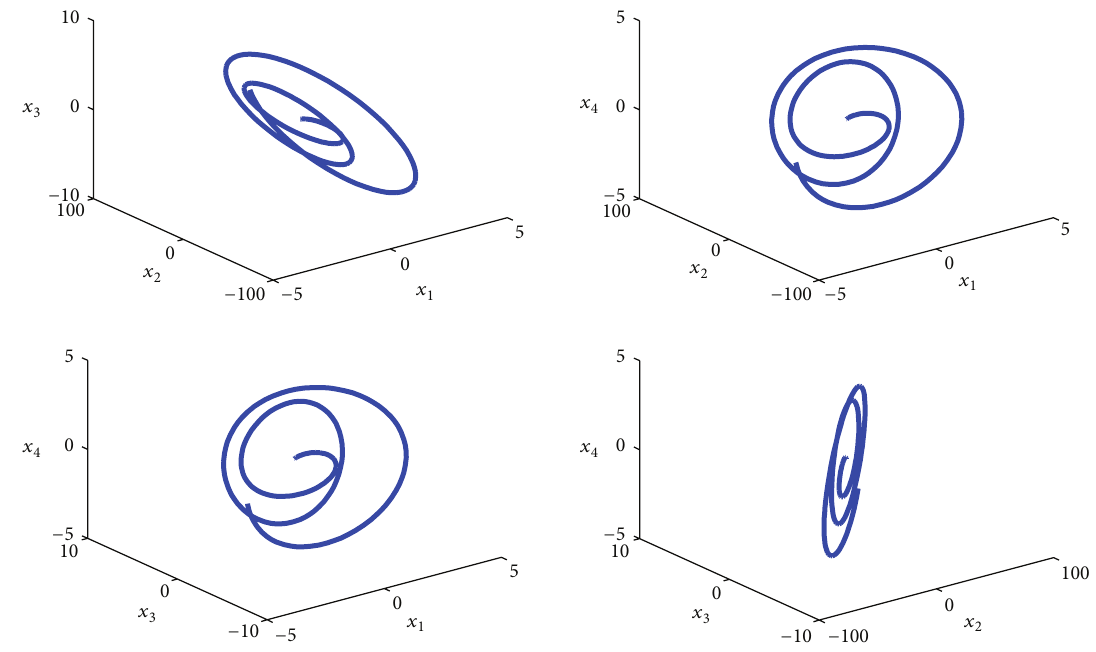
Figure 6: The states response of chaotic system.